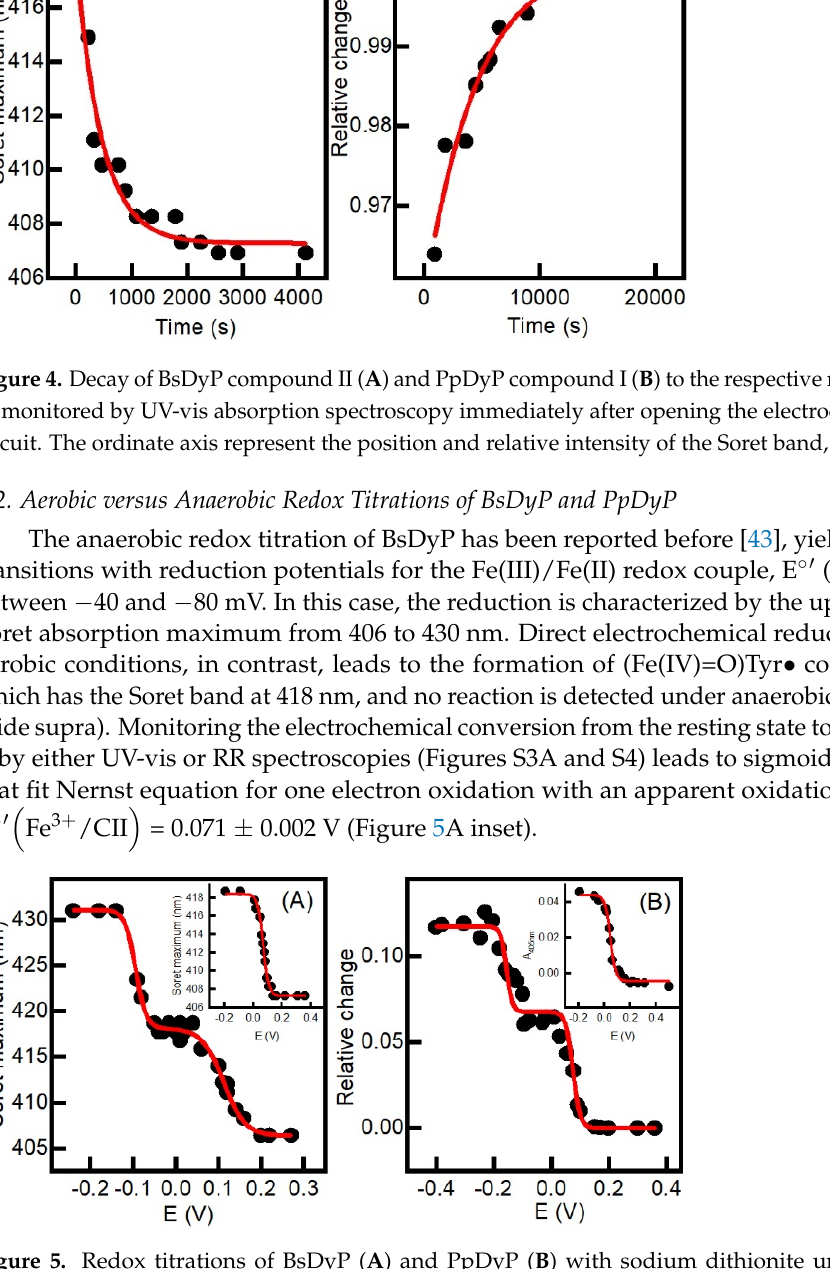
Figure 5. Redox titrations of BsDyP ( A ) and PpDyP ( B ) with sodium dithionite under aerobic conditions and monitored by UV-vis spectroscopy. The potentials correspond to the open circuit potential of the 3-electrode OTTLE cell and are reported versus NHE. The ordinate axis in panel ( A ) represents the shift of the Soret band from 406 nm to 418 nm for the formation of compound II, and from 418 nm to 431 nm for the full reduction. The ordinate axis in panel ( B ) are expressed in terms of relative change for practical purposes as the first transition, which corresponds to the formation of compound I, does not produce a shift of the Soret band but rather an intensity drop, while the second transition, which corresponds to the full reduction, implies a shift of the Soret band from 405 to 431 nm. The insets show the direct aerobic electrochemical titrations of the enzymes without addition of redox reagents. Potentials in this latter case correspond to closed-circuit values NHE.